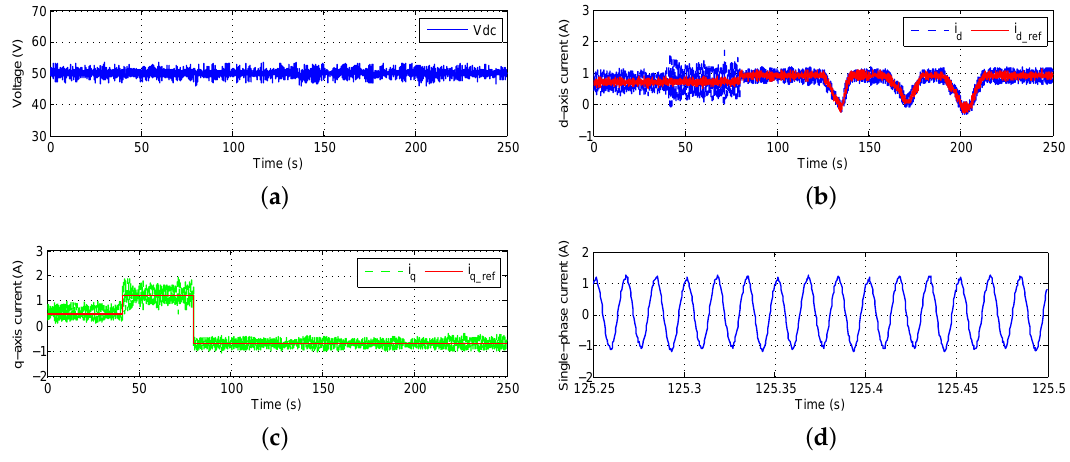
Figure 17. NN vector control for the AC/DC/DC converter with the L filter. ( a ) DC-link voltage; ( b ) PCC q -axis current waveform; ( c ) PCC q -axis current waveform; ( d ) single-phase current